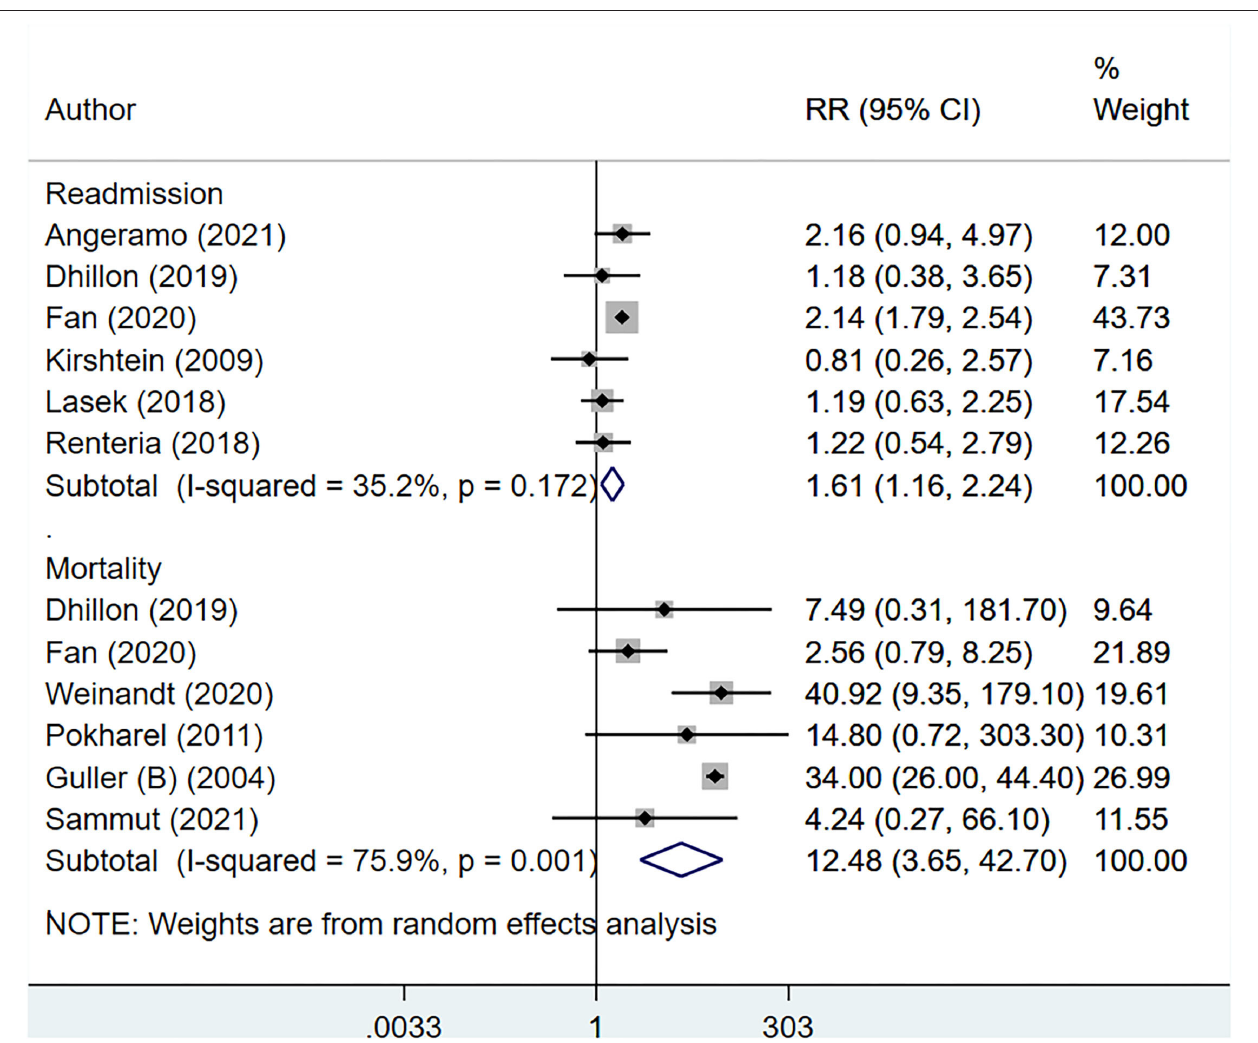
FIGURE 5 | Risk of readmission and mortality among elderly subjects, compared to non-elderly subjects.